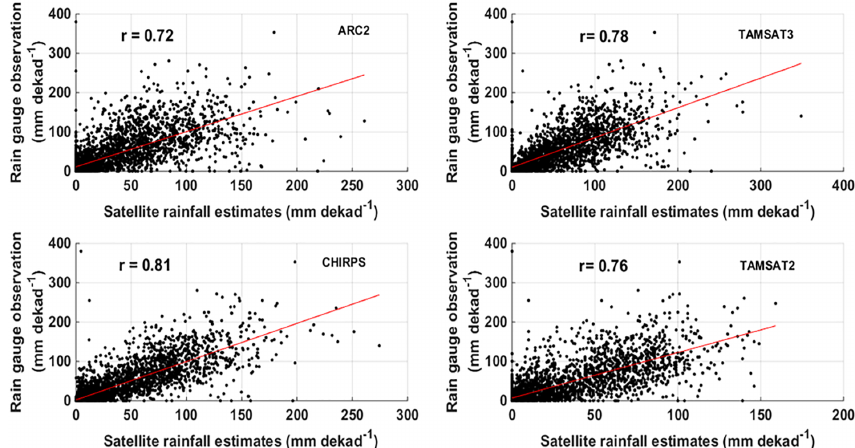
Figure 4. Scatter plot between rain gauge observations and satellite rainfall estimates at dekadal temporal scale over the Upper Blue Nile basin for the period of